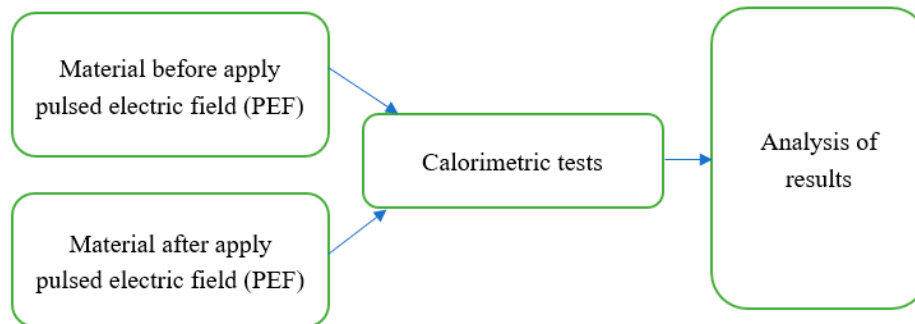
Figure 1. Schematic diagram of the experimental procedure.